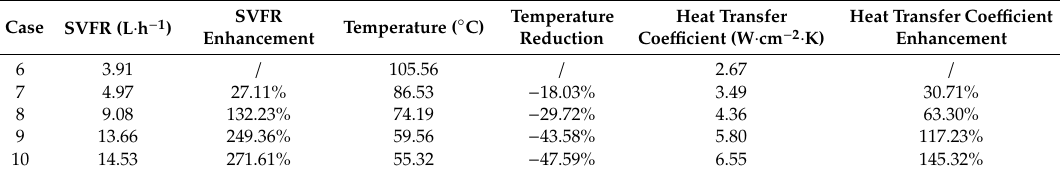
Table 5. Thermal parameters for case 6–10 at the heat flux of 221.29 W · cm − 2